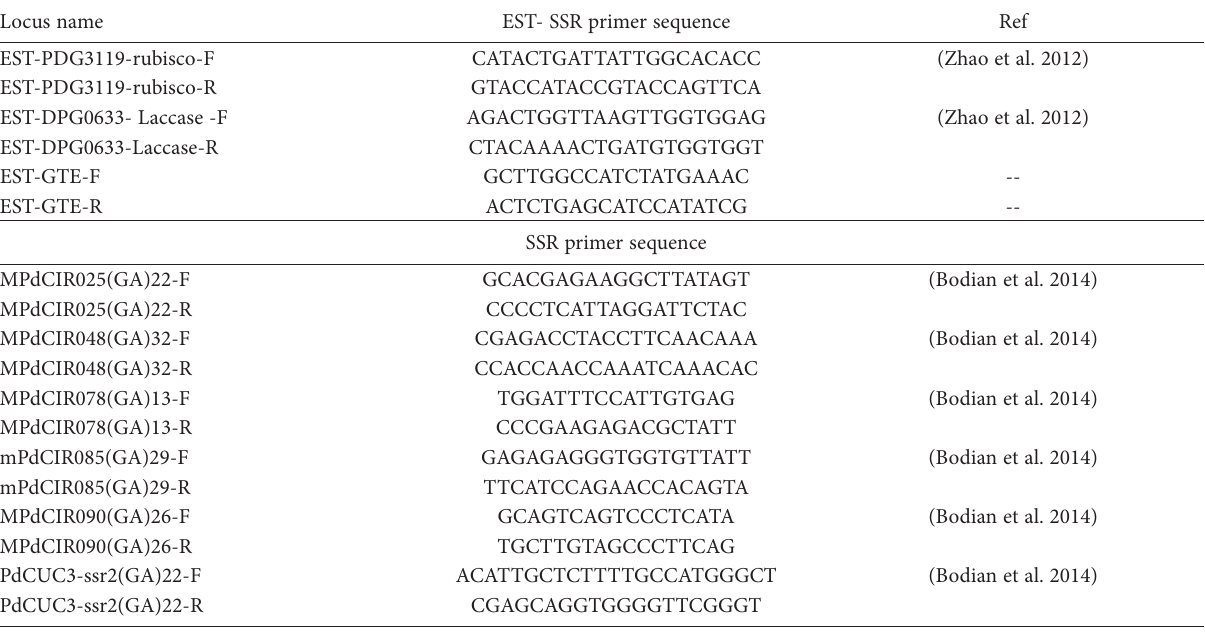
Table S1. EST-SSR and SSR primer name, sequences and